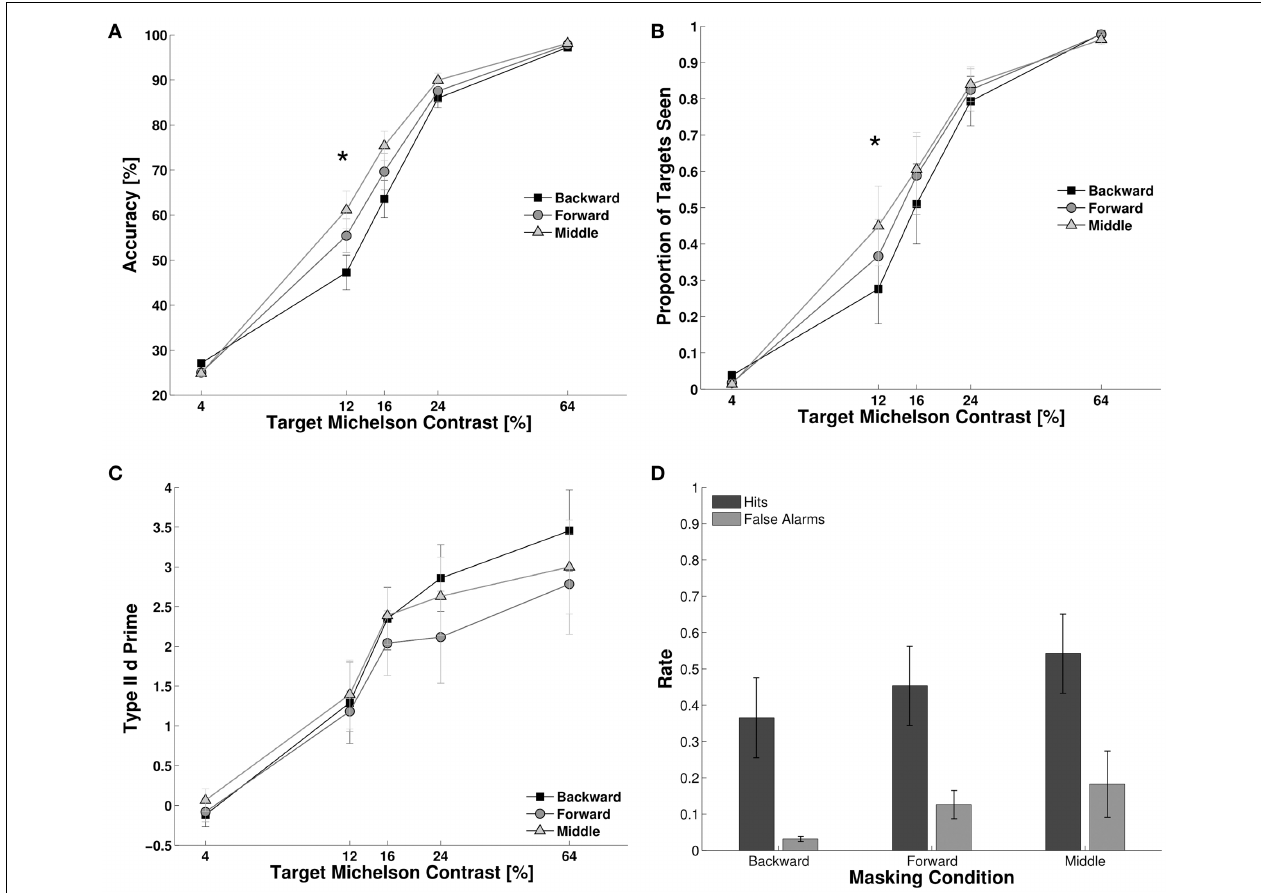
FIGURE 2 | Experiment 1. We studied the effect of our experimental conditions on target suppression. (A–C) Lower performance indicates